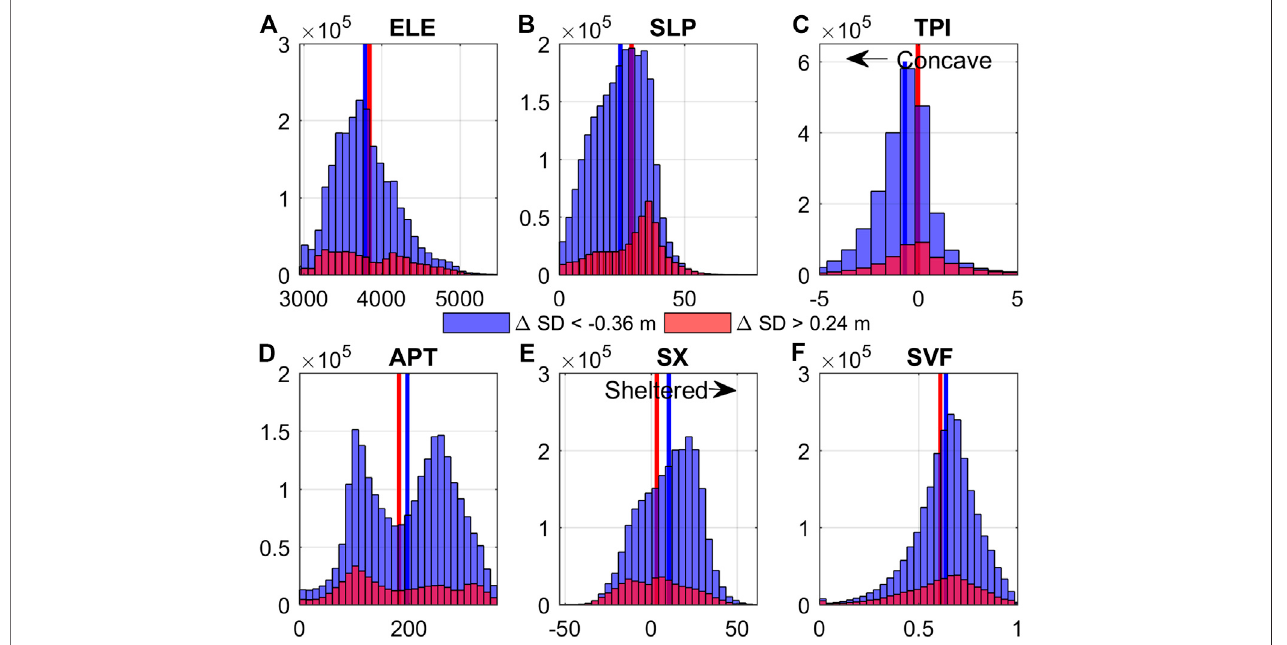
FIGURE10| Ahistogramofthefrequencyofoccurrenceofnegative(blue)orpositive(red)snowdepthdifferencefortopographicindicesoutsideoftheuncertainty band for all stable terrain ( Figure 5 ).Verticalbars showthe mean value foreach grouping. Y -axes differ. Arrows for TPIand SX are used toclarify themeaningofpositive and negative values for those indices.